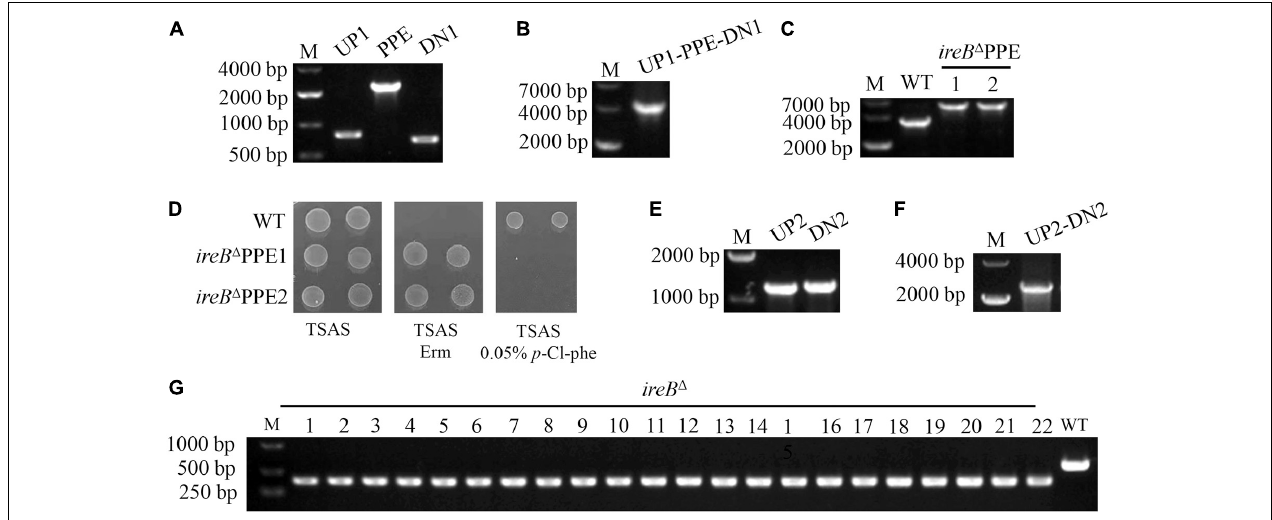
FIGURE 4 | Markerless deletion of ireB gene using the P 1503 - mPheS cassette as a CSM. (A) Amplification of upstream sequence (UP1) and downstream sequence (DN1) of ireB gene and P 1503 PE cassette. (B) Fused UP1-P 1503 PE-DN1 fragment. (C) PCR confirmation of two ireB (cid:49) PPE intermediate transformants with primers ireBseq-F/ireBseq-R. (D) Confirmation of the resistance to erythromycin and the sensitivity to 0.05% p -Cl-phe for two ireB (cid:49) PPE intermediate strains ( ireB (cid:49) PPE1, ireB (cid:49) PPE2). (E) Amplification of upstream sequence (UP2) and downstream sequence (DN2) of ireB gene. (F) Fused UP2-DN2 fragment. (G) PCR confirmation of the colonies survived from counter-selection with primers ireB-F/ireB-R.